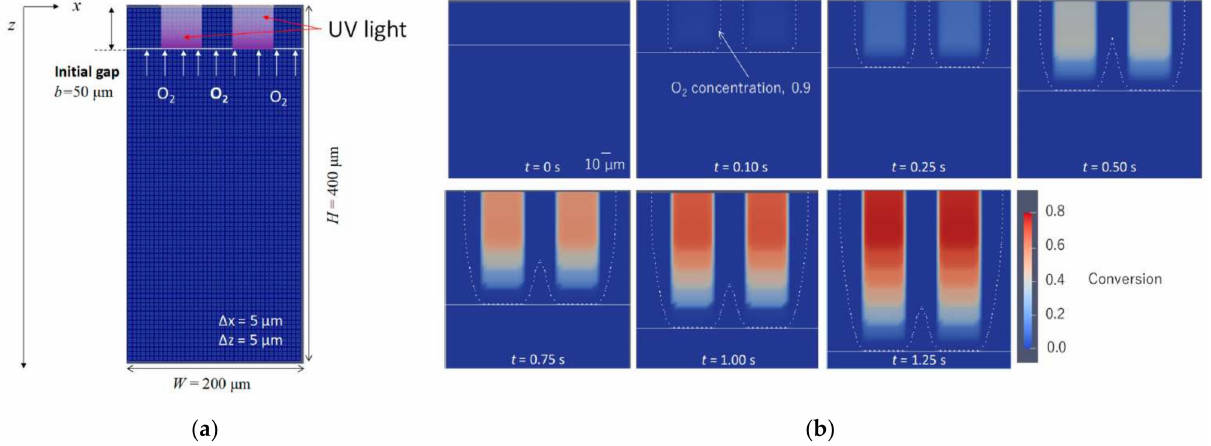
Figure 27. Simplified two-dimensional numerical simulation of photopolymerization reactions for the Continuous Liquid Interface Production (CLIP): ( a ) Geometry used for the numerical simulations; ( b ) Contour plot showing the results of the numerical simulations of C=C bond conversion as well as UV light position at a lift-up speed of 0.1 mm s − 1 [159,160]. Reprinted from reference [159] with kind permission of the